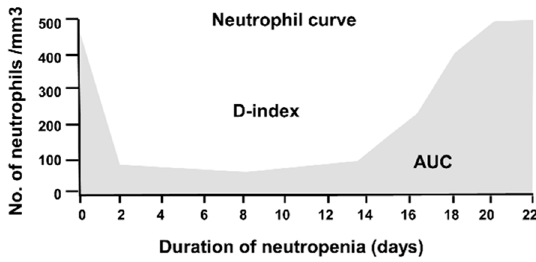
Figure 1. D ‐ index area over the neutrophil curve: AUC areas under the neutrophil curve. Figure 1. D-index area over the neutrophil curve: AUC areas under the neutrophil